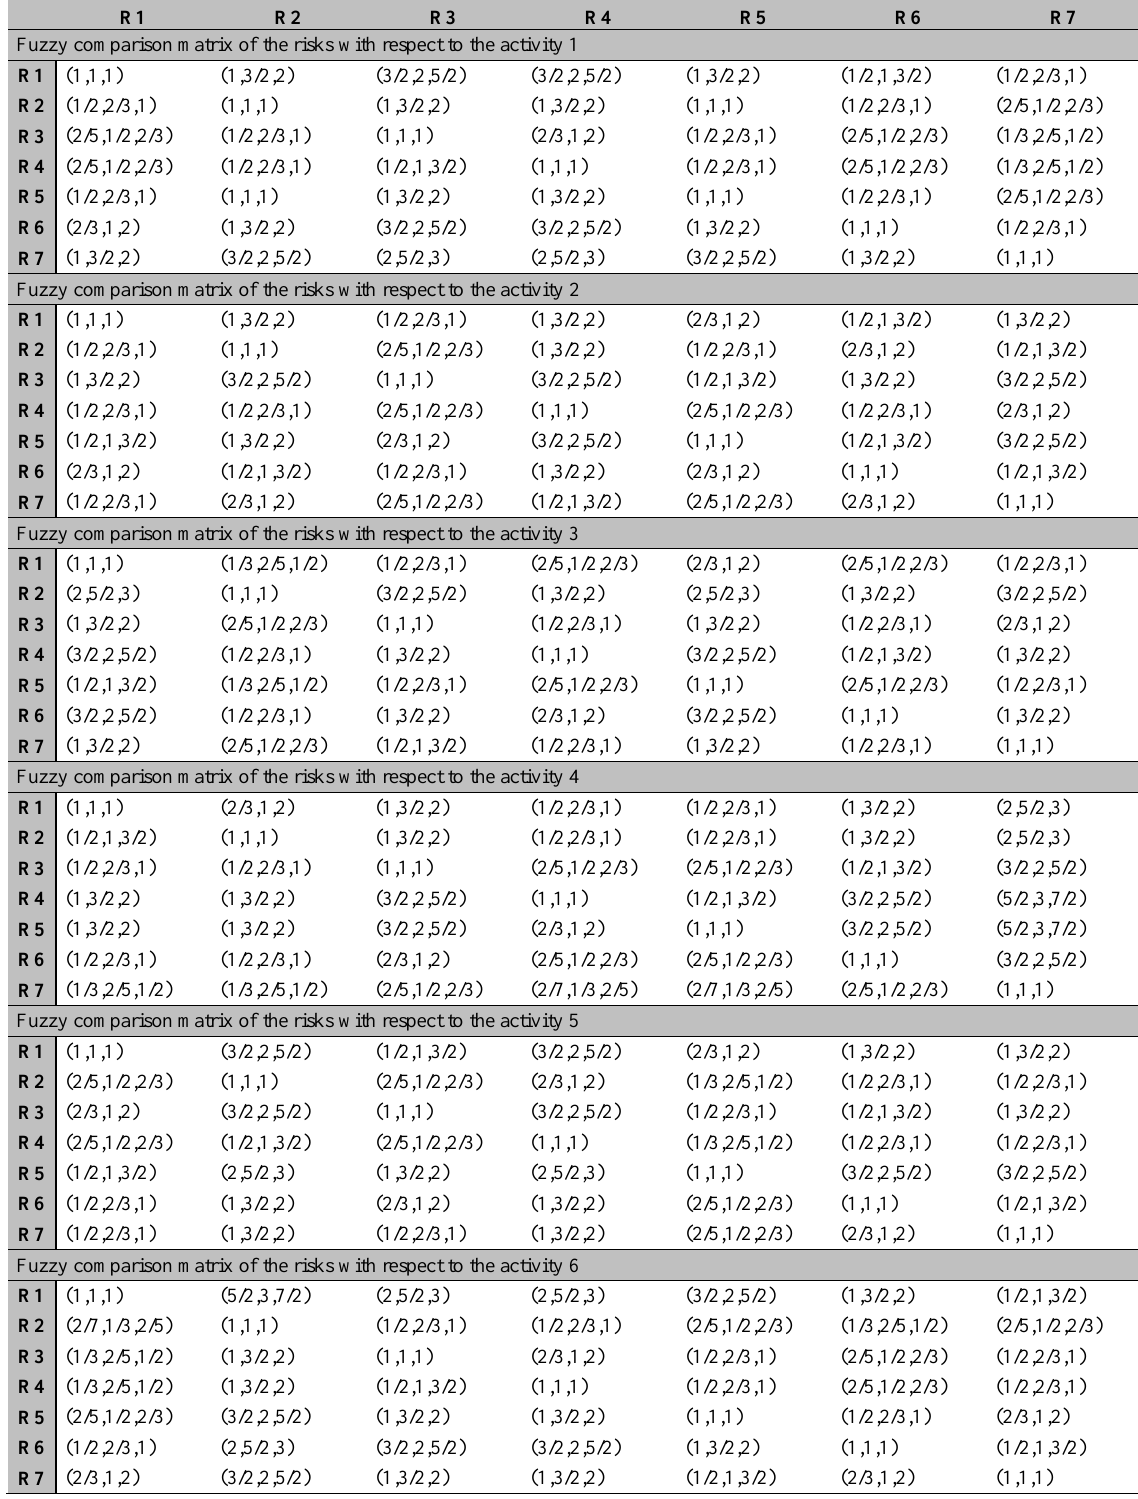
Table 6. Fuzzy comparison of risks with respect to each